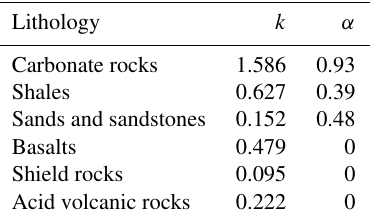
Table 1. Rock type constants used in Eqs. (4) and (5). Here, k rep- resents the weathering rate multiplier, with a higher multiplier sig- nifying a higher concentration of weathering products per unit of runoff (or alternatively, a lower resistance to weathering agents); α denotes the fraction of the given rock type to weather as carbonate rocks. A value of zero means that the rock type consists of silicate minerals